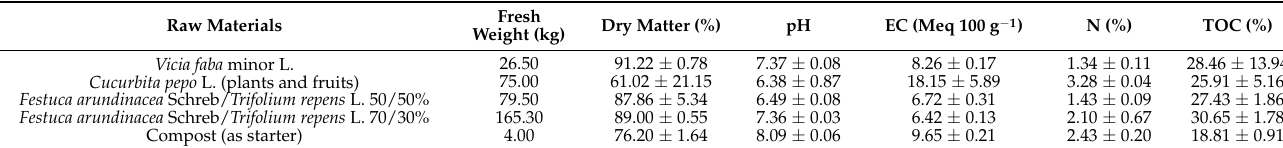
Table 1. Fresh weight, dry matter, pH, electrical conductivity (EC), total nitrogen (N) content and total organic carbon (TOC) of the raw materials used for the composting process. Raw Materials Fresh Weight (kg) Dry Matter (%) pH EC (Meq 100 g − 1 ) N (%) TOC (%) Vicia faba minor